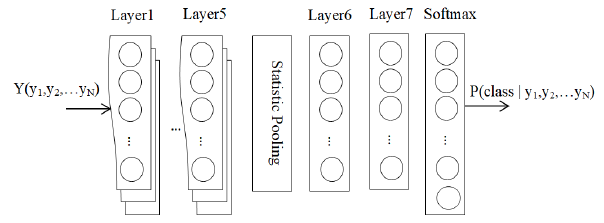
Figure 2. The stress speech recognition (SSR) system